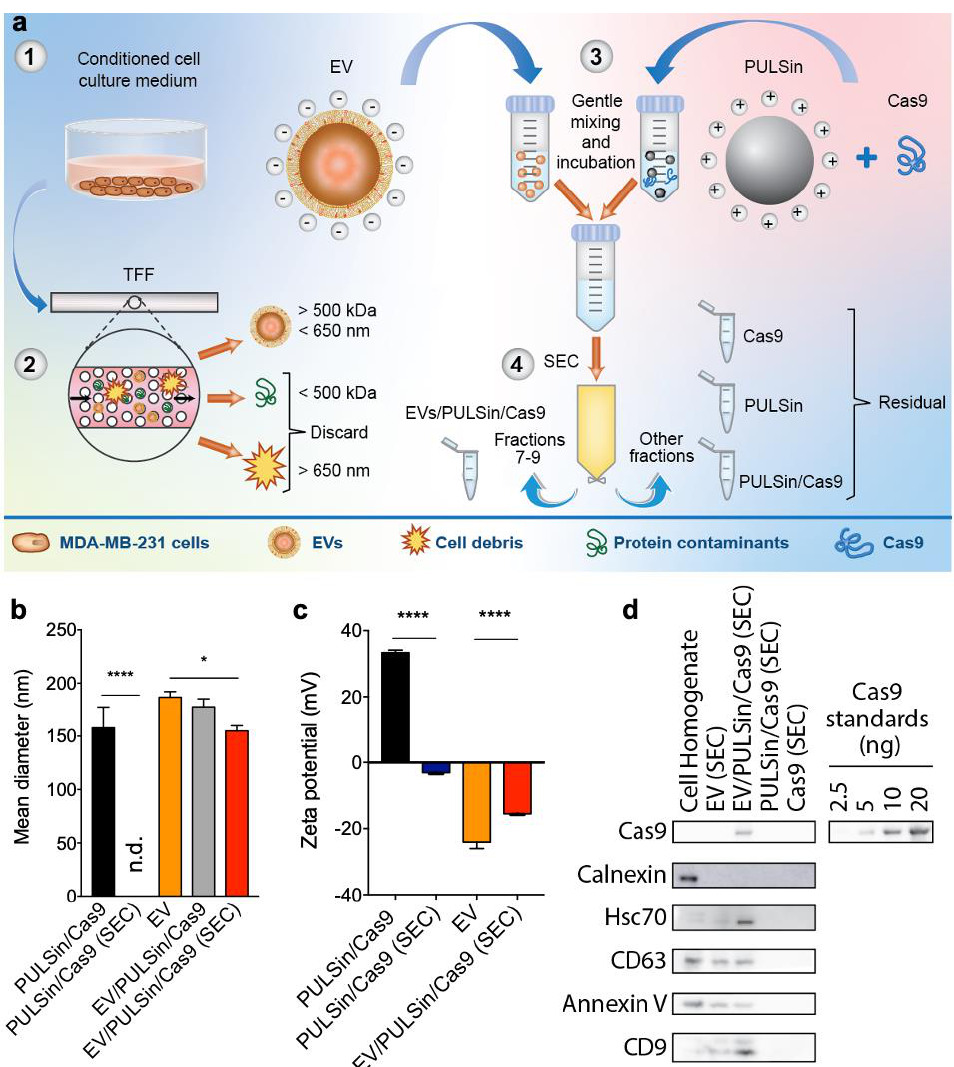
Figure 1. Characterization of extracellular vesicles (EVs) loaded with CRISPR associated protein 9 (Cas9). ( a ) Schematic of loading procedure. The conditioned medium of MDA-MB-231 human breast cancer cells was collected (step 1) and tangential flow filtration (TFF) was performed to remove components larger than 650 nm and smaller than 500 kDa (step 2). The isolated EVs were gently mixed with PULSin/Cas9 (step 3) and size-exclusion chromatography (SEC) was used to remove free Cas9, PULSin and Cas9/PULSin (step 4). ( b ) Mean size determined by nanoparticle tracking analysis (NTA). ( c ) Zeta potential measured by laser Doppler micro-electrophoresis. ( d ) Cas9 loading and protein markers of EVs, heat-shock cognate protein 71 (Hsc70), cluster of differentiation (CD)63, CD9 and annexin V, and intracellular contaminant marker, calnexin, detected by Western blot. Data are presented as mean ± SD of three biological replicates (b and c). Statistical analysis was performed by one-way analysis of variance (ANOVA) with post-hoc pairwise comparisons using Tukey’s test. *, p < 0.05; ****, p <